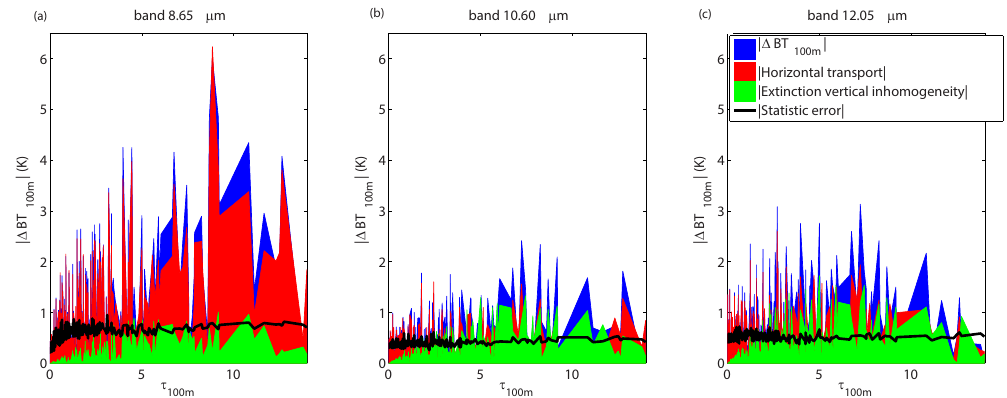
Figure 8. Absolute brightness temperature differences at 100m × 100m 1 BT 100m (in blue) due to the horizontal transport (in red), the extinction vertical variability (in green) and the statistical error of the code (black line) for cirrus 5. Results are presented for the bands at 8.65µm, 10.60µm and 12.05µm.